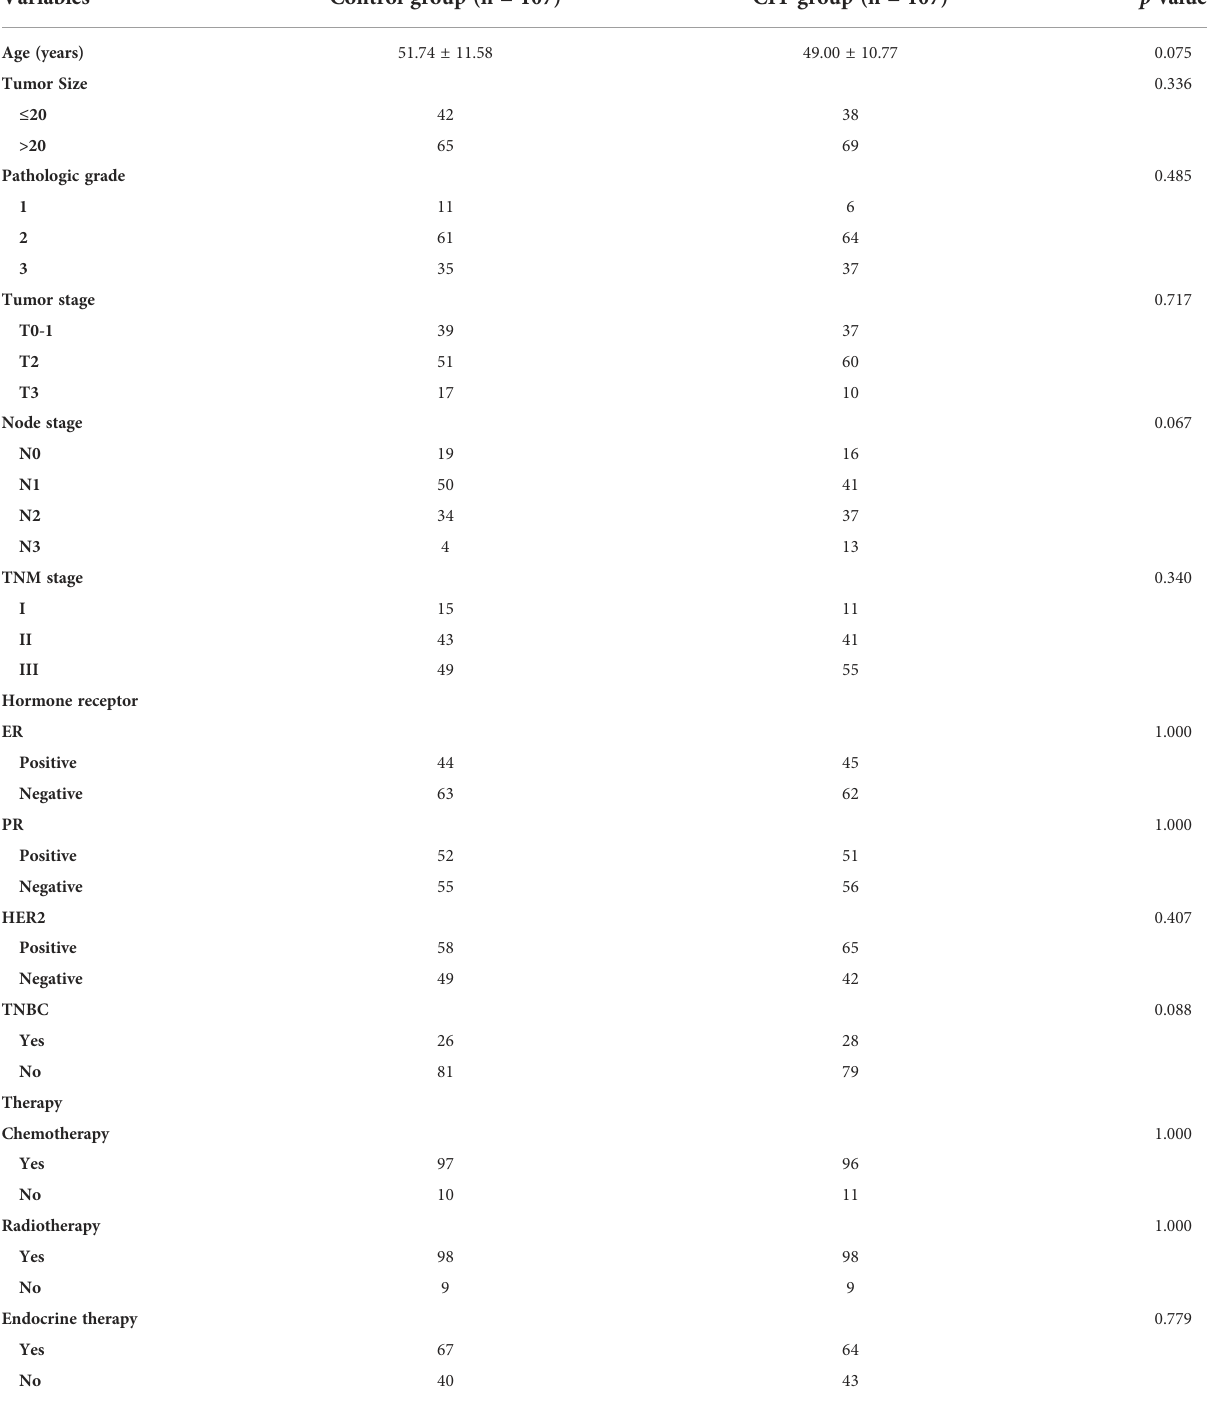
TABLE 1 Demographics and disease characteristics of patients in the control group patients and the cellular immunotherapy group